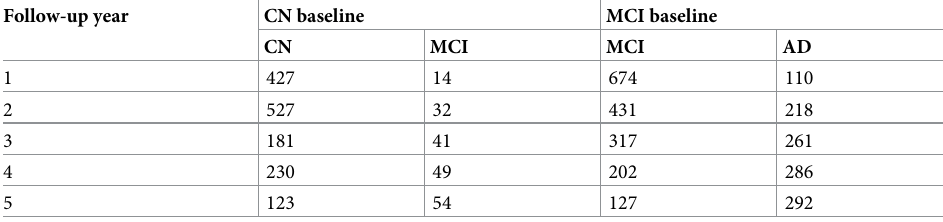
The follow-up diagnoses are not actually exactly 12 months apart. They have been rounded to the nearest time horizon in